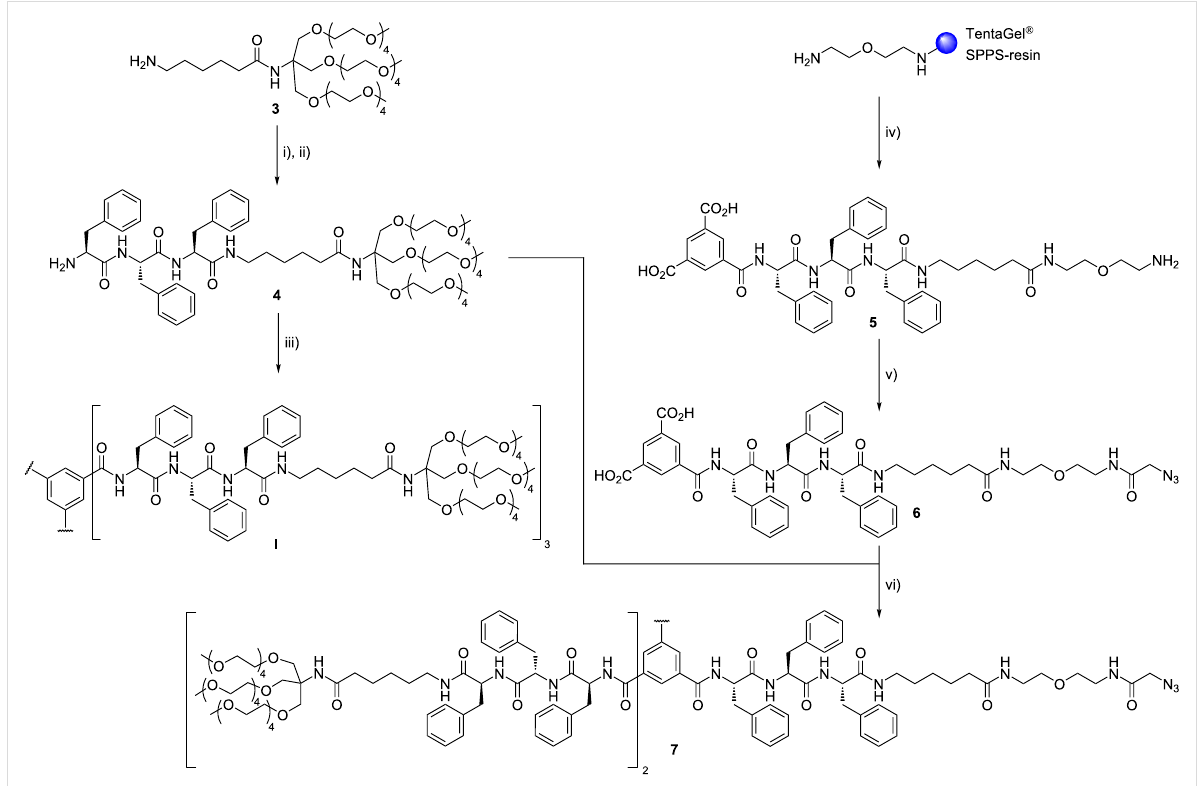
Scheme 1: The synthesis of the C 3 -symmetrical tetraethylene glycol-decorated peptide amphiphile I and the azide-functionalized peptide amphiphile 7 : i) Boc-PhePhePhe-OH, HBTU, HOBt, DIPEA, DMF, 0 °C to rt, 15 h, 85%; ii) TFA/TIS/H 2 O 9.5:0.25:0.25 (v/v/v), rt, 1 h, 98%; iii) BTA,